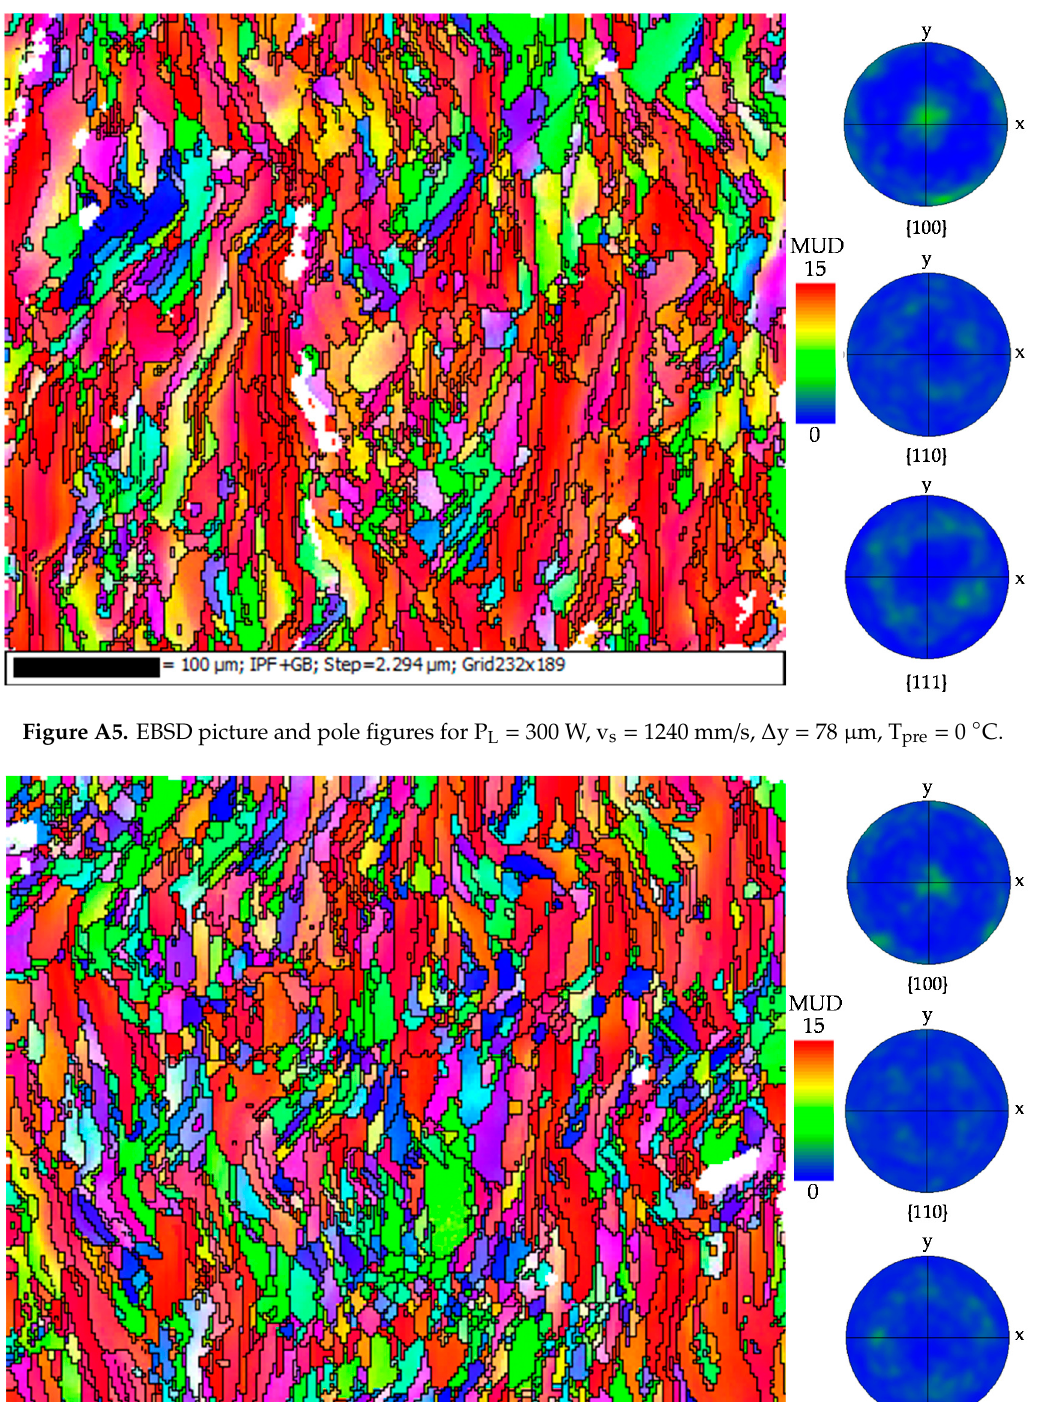
Figure A4. EBSD picture and pole figures for P L = 200 W, v s = 83 mm/s, Δ y = 70 µm, T pre = 3500 °C.